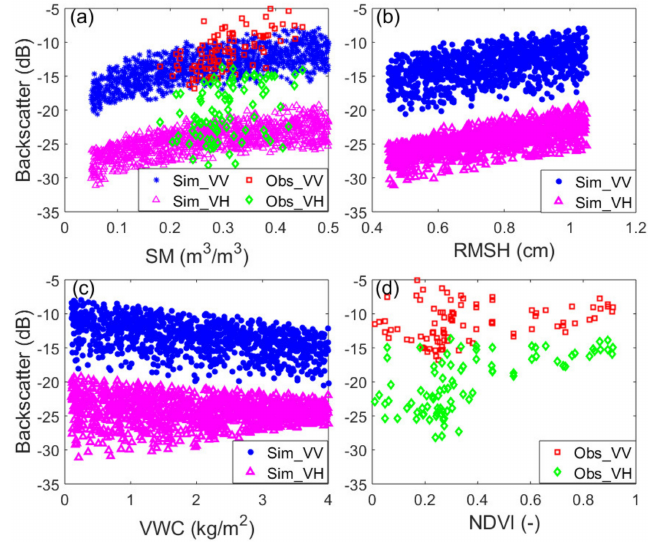
Figure 4. Response of the water cloud model simulated (blue star and pink triangle) and Sentinel-1 observed (red square and green diamond) backscatters to: ( a ) soil moisture; ( b ) root mean of the surface height (RMSH); ( c ) VWC; and ( d ) NDVI. Both simulated and observed backscatters increase with increasing soil moisture and RMSH, with no significant changes in simulated backscatter to VWC. The observed VV-backscatter slightly decreases with NDVI increasing and VH-backscatter increases with NDVI